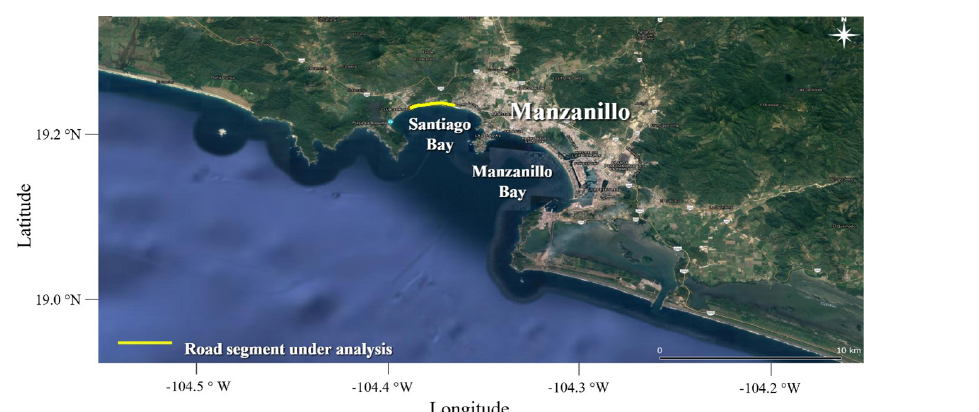
Figure 4. Location of the road embankment analysed (© Google Earth).